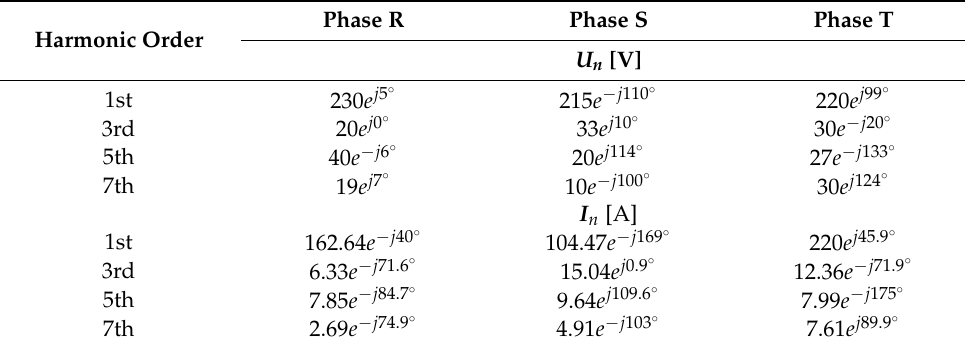
Table 2 presents the values of the voltages harmonics and the values of the harmonics of the line currents of the load. Table 2. List of the values of the phase voltages and the values of the line currents. Phase R Harmonic Order